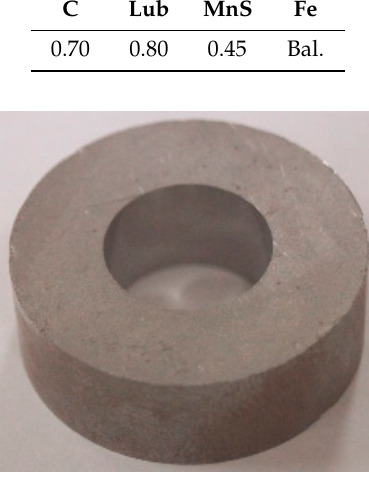
Figure 1. A picture of the sintered sample.